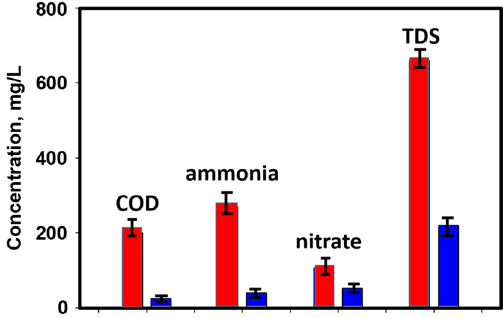
Fig. 7 Batch treatment of Buriganga river water with standard errors on average. Volume: 500 mL, adsorbent (taro carbon) dosage: 5 g [red mark: untreated water; blue mark: treated